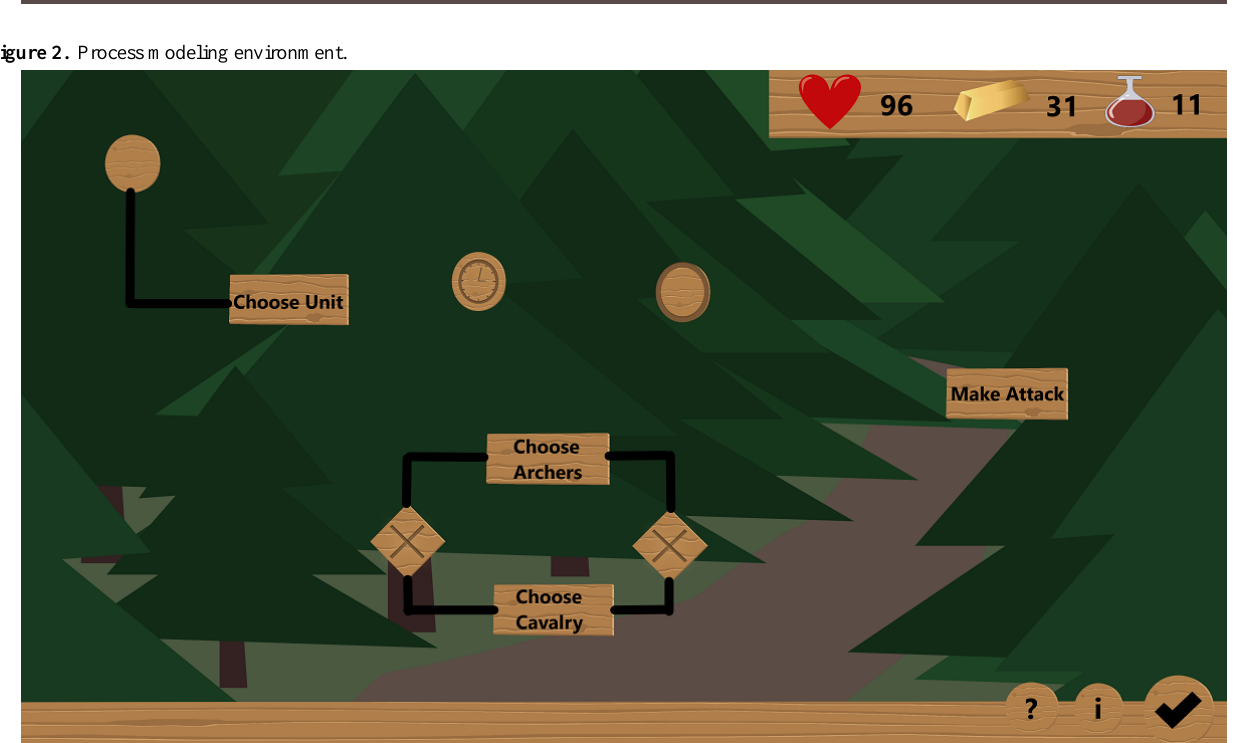
Figure 2. Process modeling